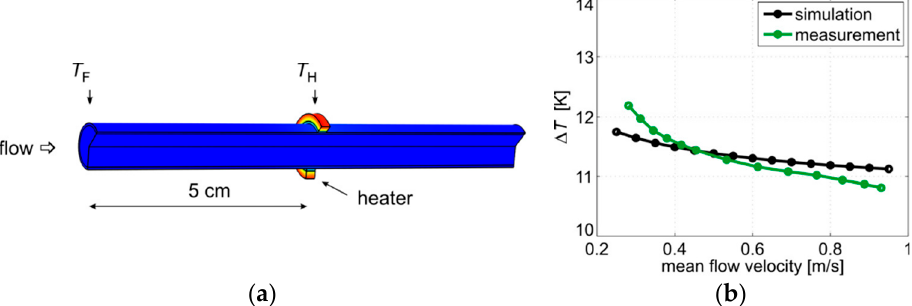
Figure 2. ( a ) FEM model of the sensor; ( b ) Heater excess temperature as a function of the mean flow velocity (simulation and measurement results at 7 W heating power).